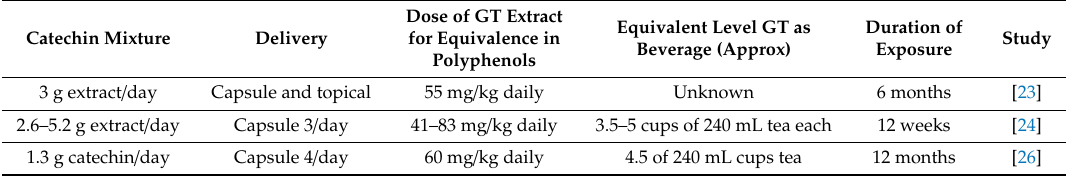
Table 2. Green Tea Polyphenol Clinical